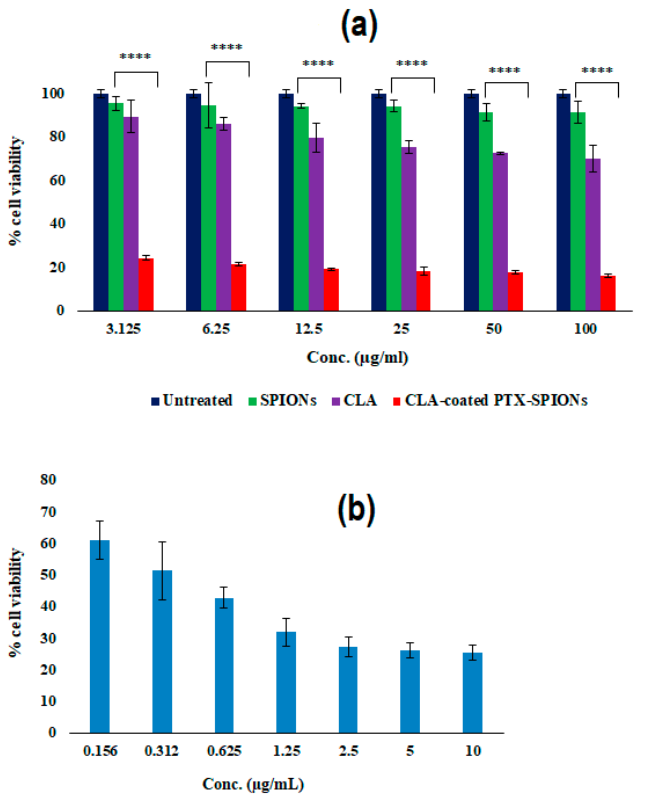
Figure 8. Profiles showing % cell viability of lung adenocarcinoma cells (A549) treated with varying concentrations of ( a ) pristine SPIONs (negative control) and the CLA-coated PTX-SPIONs, and ( b ) pristine PTX (positive control) after 72 h. Data presented as mean ± SD, n = 3 (**** denote p < 0.0001, when CLA-coated PTX-SPIONs are compared to SPIONs and CLA at the same concentrations).